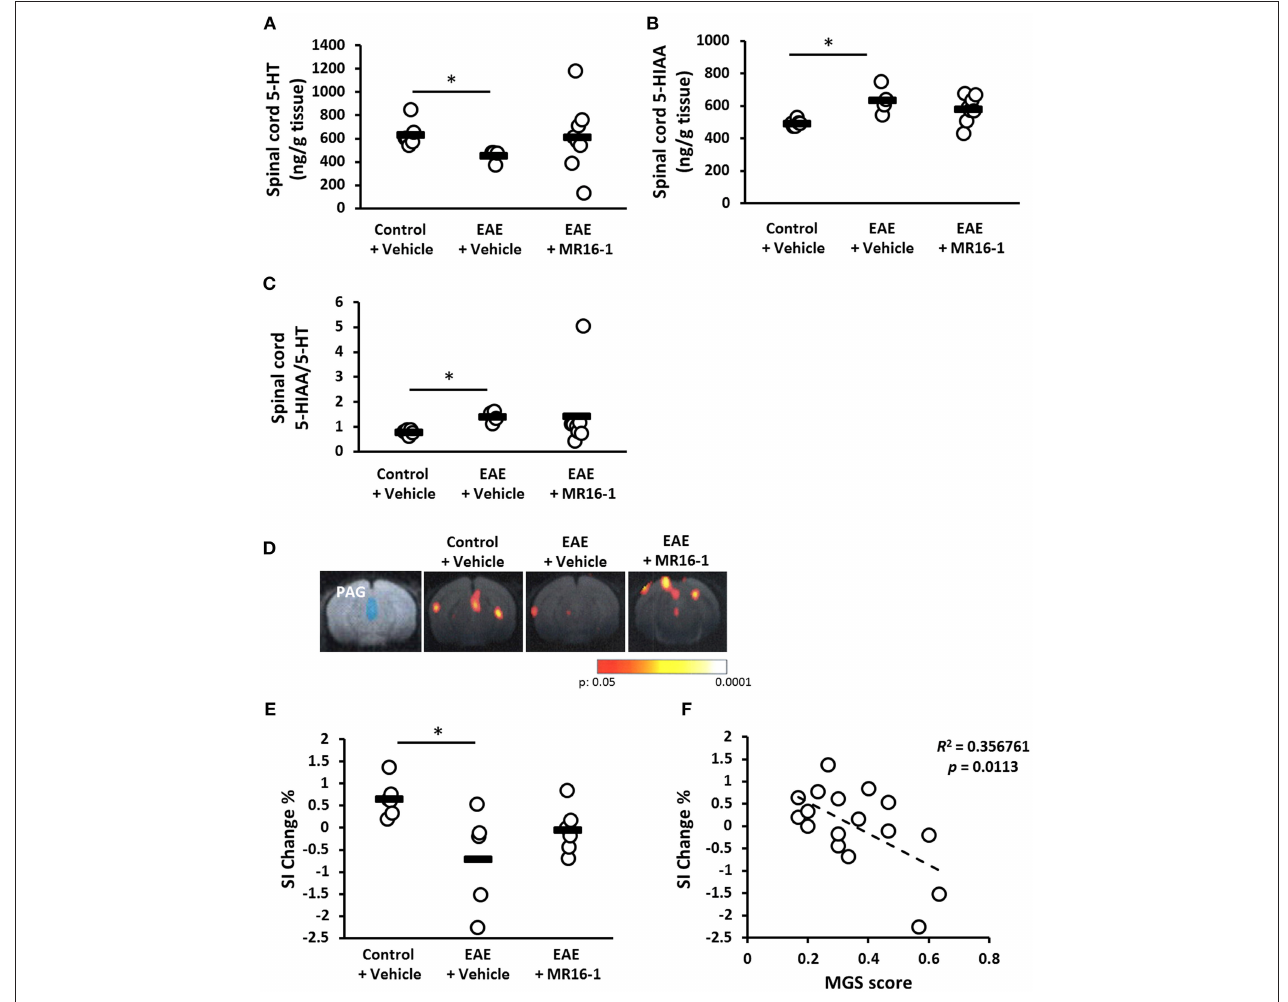
FIGURE 2 | Effects of administration of MR16-1 on the descending pain inhibitory system in pre-onset EAE mice. (A–D) Spinal 5-HT and 5-HIAA was measured in control and pre-onset EAE mice (clinical score 0) on Day 20 after immunization. Levels of spinal 5-HT were decreased in EAE mice (A) . Levels of spinal 5-HIAA, the major metabolite of 5-HT, were increased in EAE mice (B) . 5-HIAA/5-HT ratio was increased in EAE mice (C) . * p < 0.05 vs. Control + Vehicle by Steel-Dwass test ( n = 4 – 8 per group). (D) Representative images of BOLD responses in the PAG. Blue area indicates PAG. Red and yellow areas show significant changes of BOLD signals. (E) The changes of BOLD signals in PAG were significantly decreased in pre-onset EAE mice. (F) There is a negative correlation between the changes of BOLD signal intensity in PAG and MGS score. Black bars indicate the mean value of each measurement. * p < 0.05 vs. Control + Vehicle by Tukey’s multiple comparison test ( n = 5–6 per